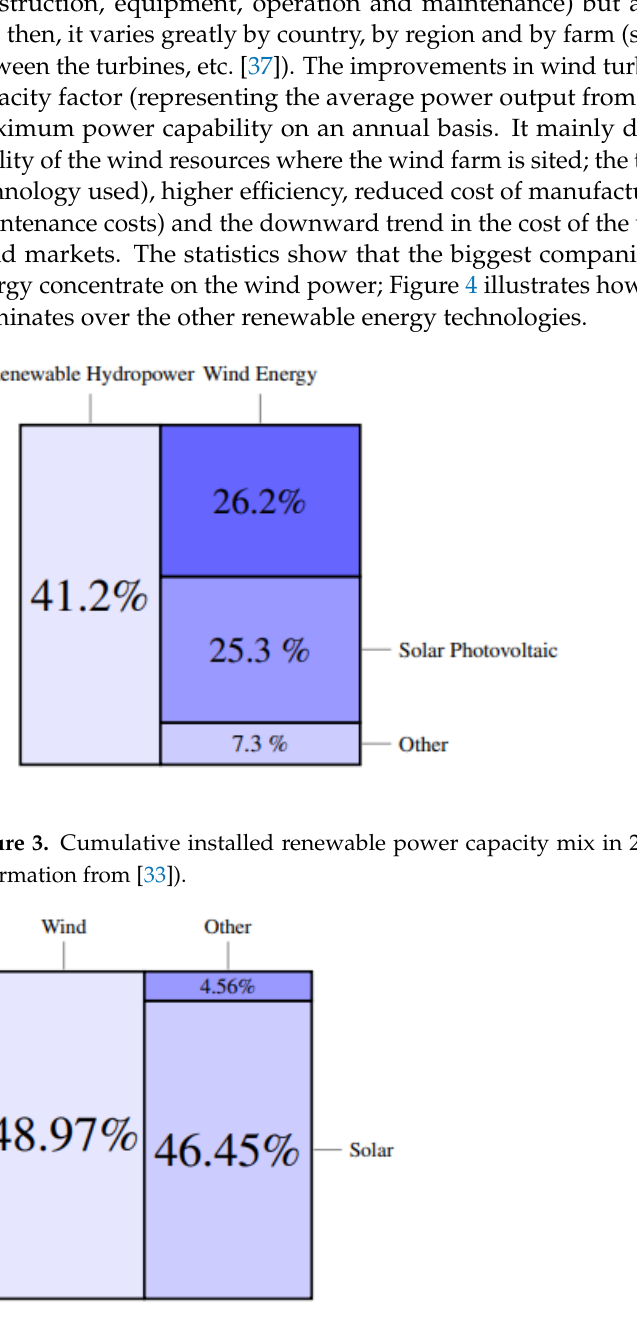
Figure 4. Global investment in renewable energy in 2019 (own representation with information from